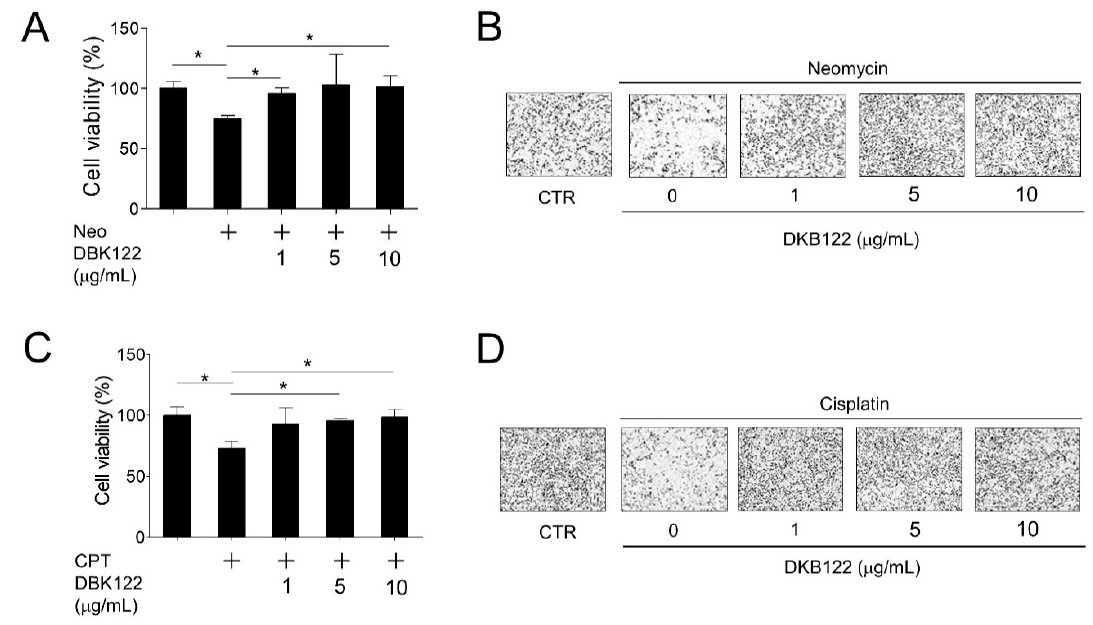
Figure 1. Enhanced functional avocado oil extract ( DKB122) protects HEI-OC1 cells from chemical-induced cell death. (A, B) HEI-OC1 cells were pretreated with DKB122 (1–10 μ g/mL) for 1 h, then incubated with neomycin (10 mM) for 24 h. Cell viability was determined and visualized by IncuCyte. The results are presented as mean ± SD of three independent experiments ( n = 3); * P < 0.05. (C, D) HEI-OC1 cells treated with DKB122 (1–10 μ g/mL) for 1 h, followed by the addition of cisplatin (CPT, 30 μ M) for 24 h. Cell viability was determined and visualized by IncuCyte. The results are presented as mean ± SD of three independent experiments ( n = 3, * P < 0.05).